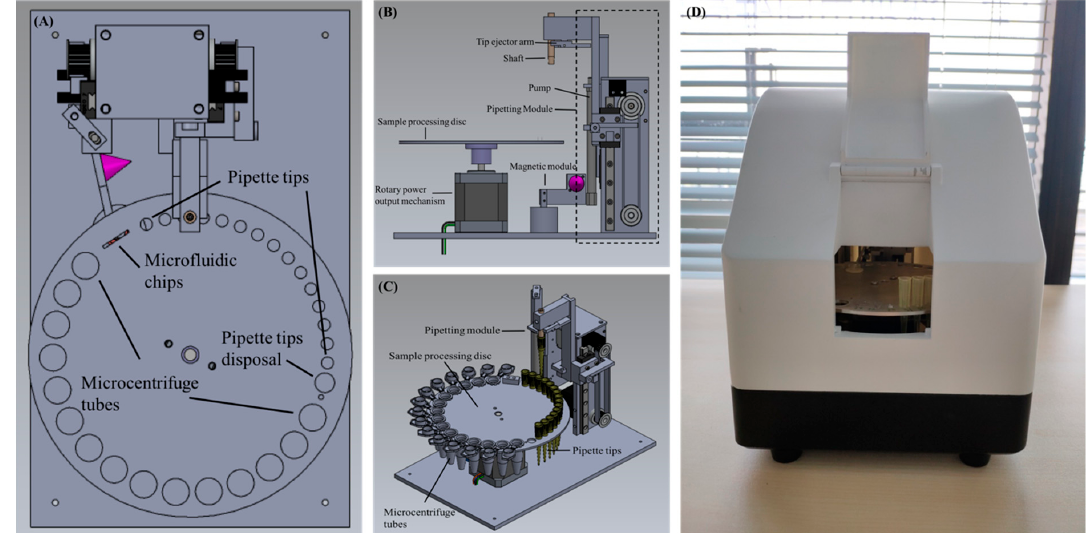
Figure 2. Schematic diagram of the automated miniaturized rotary sample preparation device. ( A – C ) Top, front, side and isometric view of the device. ( D ) Actual image of the device with all modules integrated in a portable box.